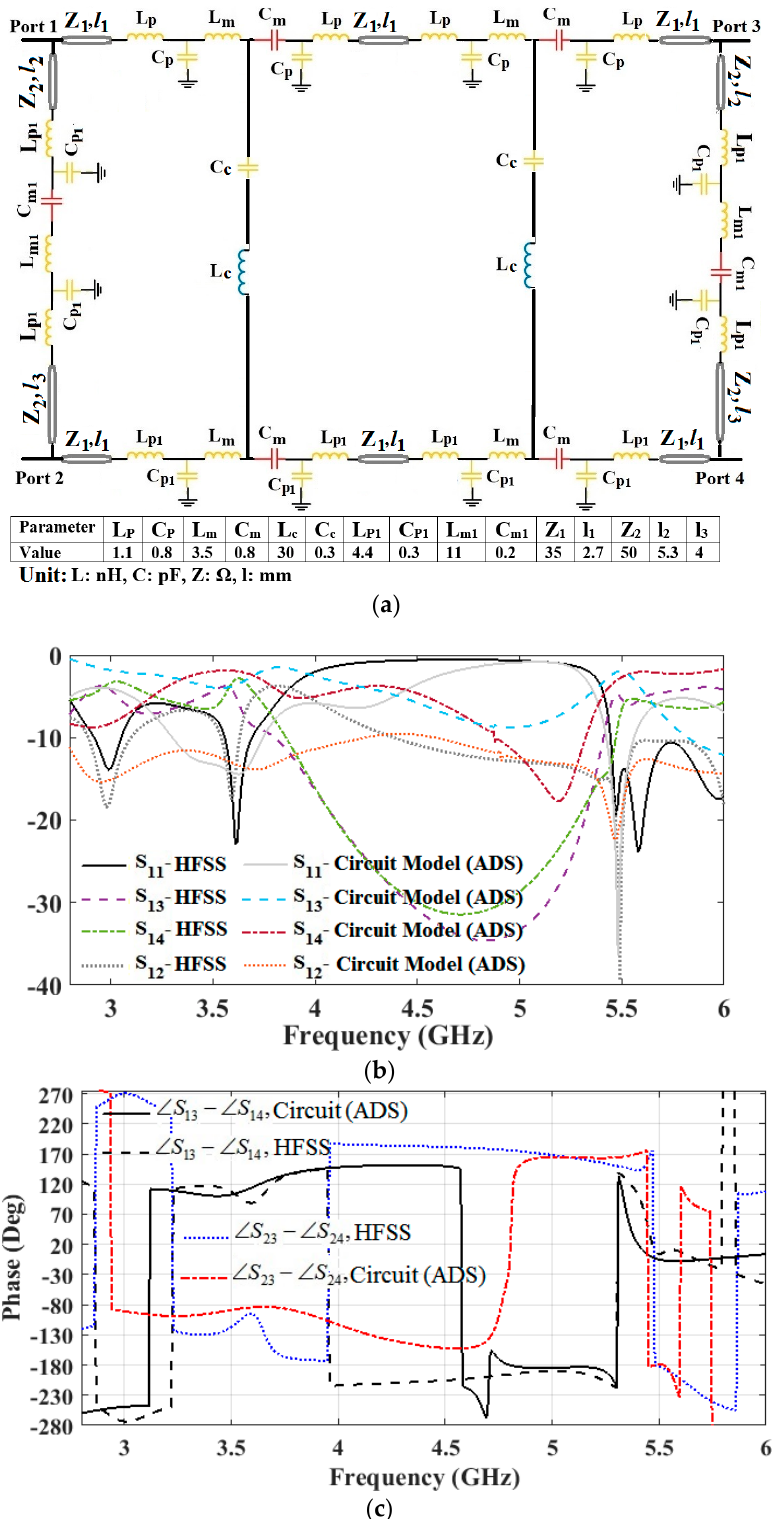
Figure 5. ( a ) Accurate circuit model of the proposed coupler with artificial TLs based on OSRR with the obtained elements values, ( b ) amplitude response of the S-parameters of the coupler by using the circuit and EM simulations: ( c ) phase difference of the outputs of the proposed coupler.